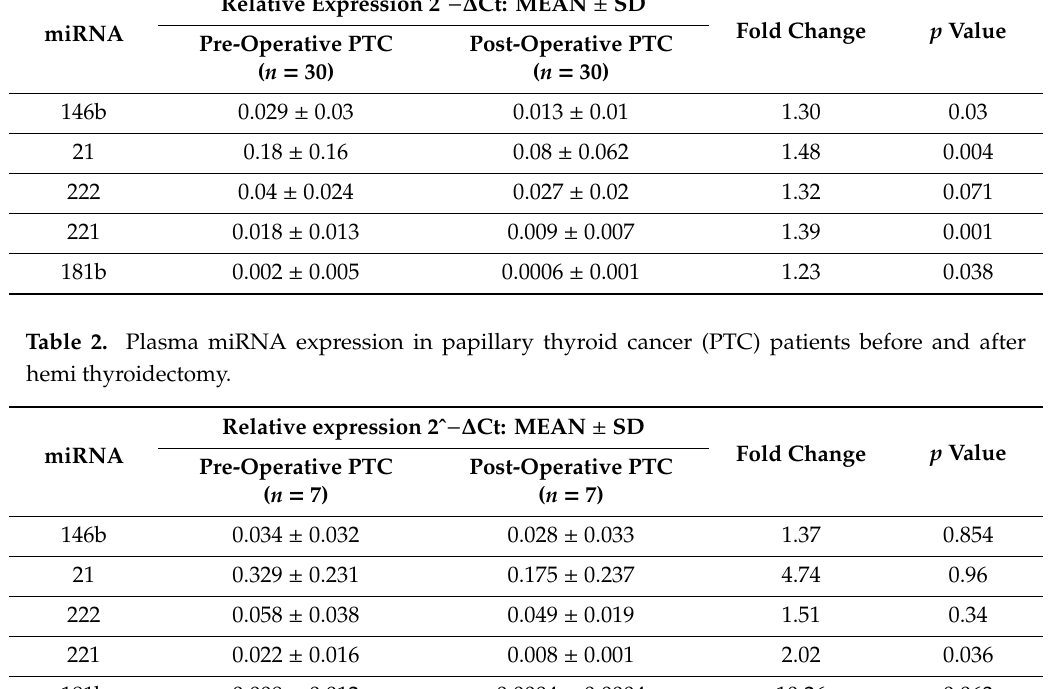
Fold Change p Value